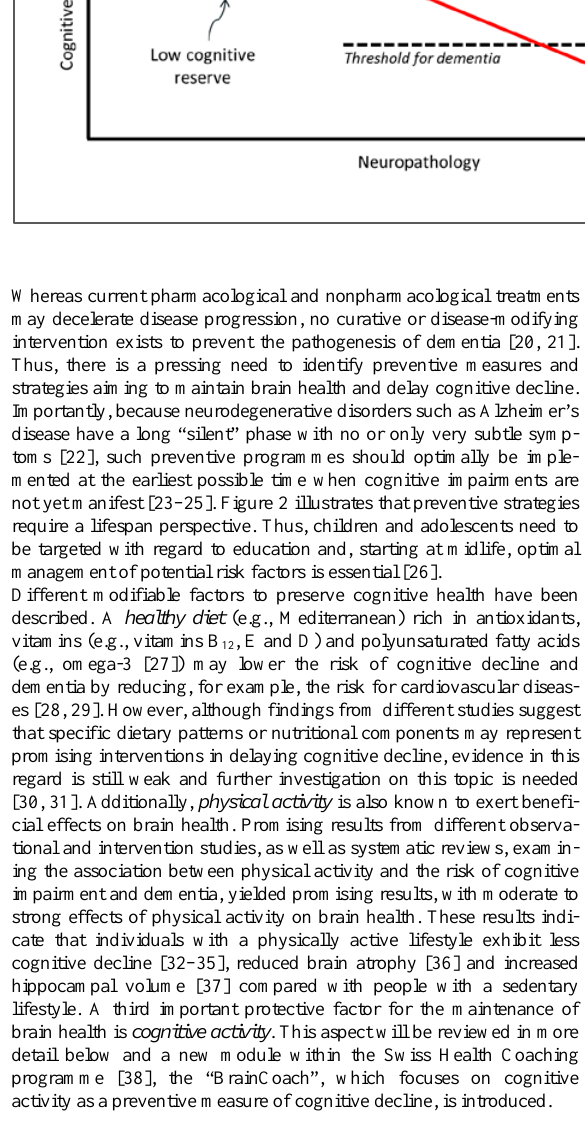
Figure 3: Illustration of the association be- tween the emergence of dementia-associated neuropathology, its clinical expression and cognitive reserve. Figure adapted from [45]; reproduced with permission. Educational attainment and occupational challenges can usually no longer be changed in individuals aged 50 years and older. However, cognitive leisure activities may increase their cognitive reserve and thus lead to a delay in the emer- gence of cognitive